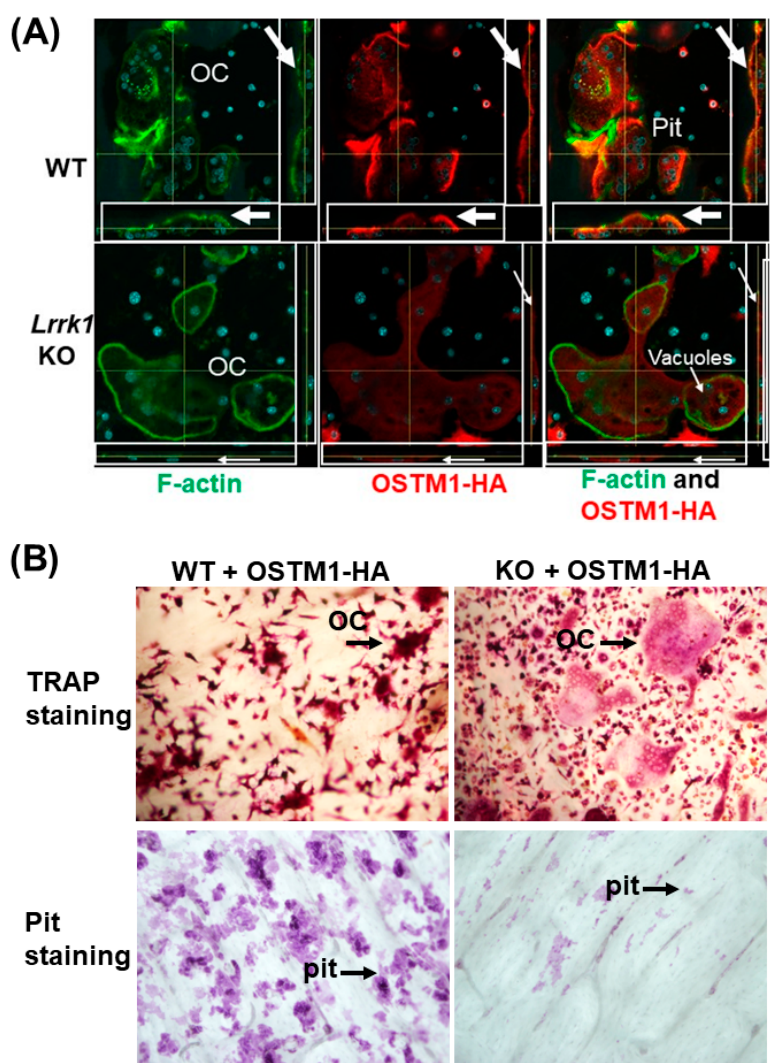
Figure 6. LRRK1-deficient osteoclasts are not able to transport OSTM1 to the peripheral ruffled border. ( A ) Differentiated osteoclasts on bone slices were probed with anti-HA antibody, followed by staining with a rhodamine-conjugated second antibody from rabbit. F-actin of the osteoclasts was stained with Alexa fluor-488 conjugated phalloidin. Nuclei were stained with DAPI. Immunofluorescent staining was analyzed by a confocal microscope. The two lines in the middle of the cell represent the positions of horizontal and vertical cuts, respectively. Arrows indicate F-actin and HA-OSTM1 fusion protein associated with a pit on the horizontal and vertical cross-sections of WT but not LRRK1-deficient osteoclasts. Enlarged vacuoles were frequently seen in LRRK1 deficient osteoclasts. ( B ) Images of active WT and LRRK1 deficient osteoclasts (OCs) stained with TRAP and the resorbed bones stained with hematoxylin for pits (100 × ). The osteoclasts derived from the WT and Lrrk1 KO mice were transduced with Lenti-OSTM1-HA and Lenti-CLC7-myc